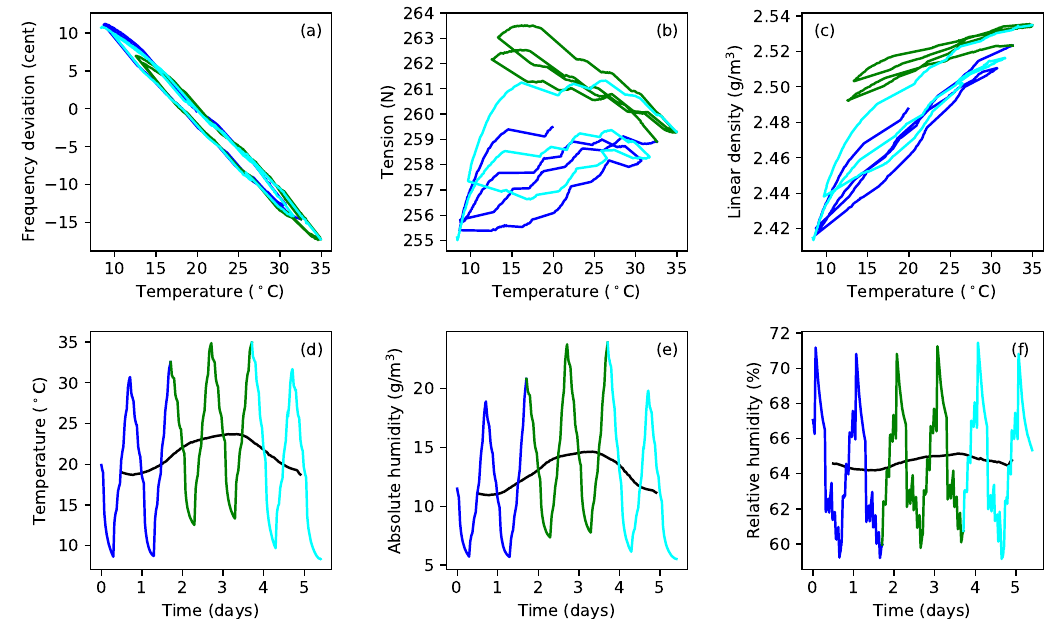
Figure 12. ( a ) The frequency deviation, ( b ) tension, and ( c ) linear density responses to temperature changes for the constant-length test with gut string G5c at a target fundamental frequency of 324 Hz. The variation in the tension and linear density response gradients appear more likely to correspond to a change in ( d ) the overall temperature or ( e ) the absolute humidity level, than to a change in ( f ) the relative humidity. The black lines show the average levels over a rolling 24-h period. The tuning sensitivity seems remarkably una ff ected.